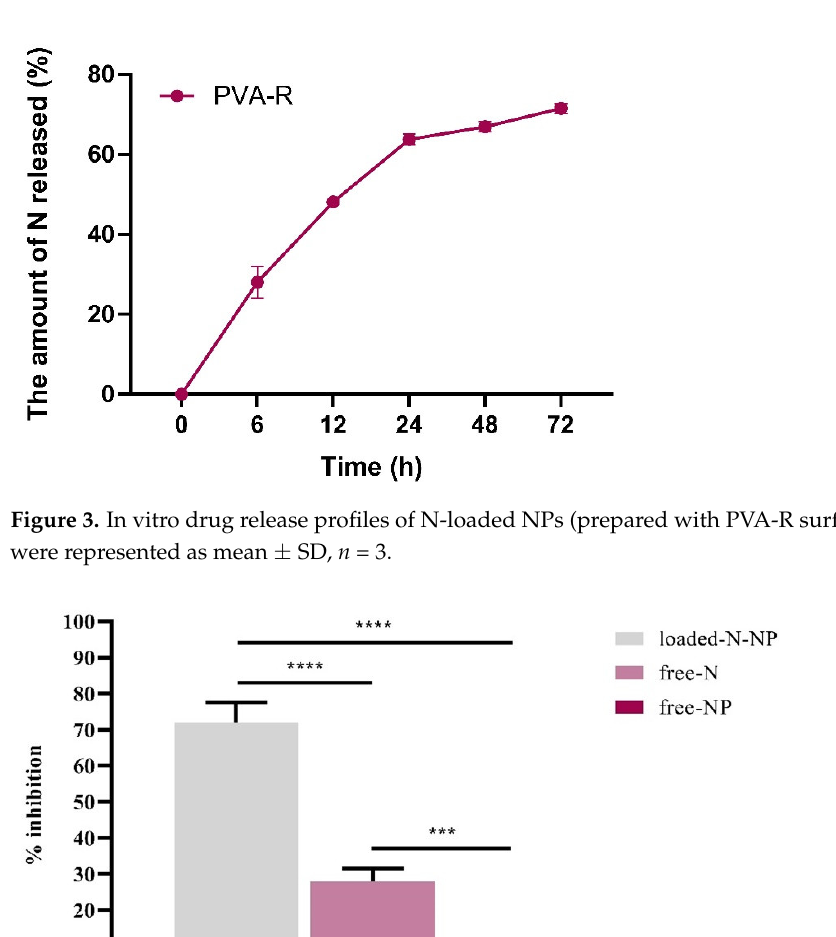
Figure 3. In vitro drug release profiles of N-loaded NPs (prepared with PVA-R surfactant). Results were represented as mean ± SD, n = 3.